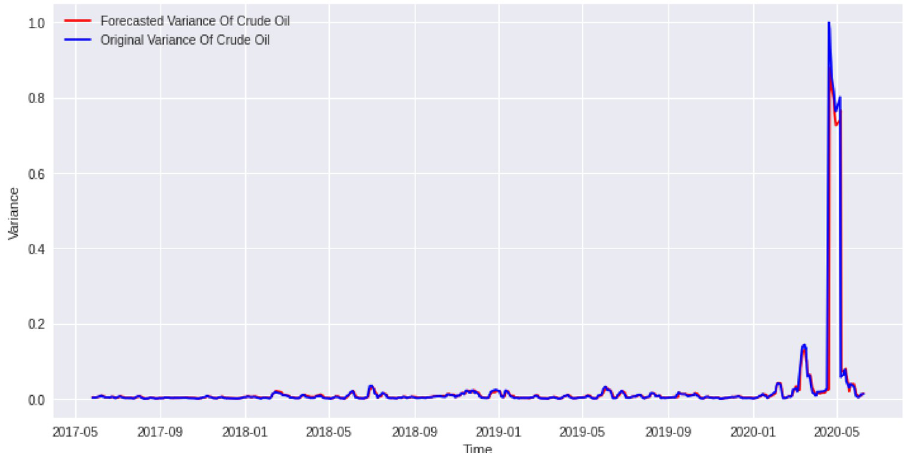
Fig 15. Forecasted values vs actual values of daily crude oil price variance from May 2017 to June 2020. The lookback period is 1 day. The number of epoch is 68. The activation function is ‘tanh’. and the gradient descent optimizer is “ Adam ”. It gives a R-squared of 80.18%. We can see that our model rightly predict the crude oil April 20, 2020, high volatility